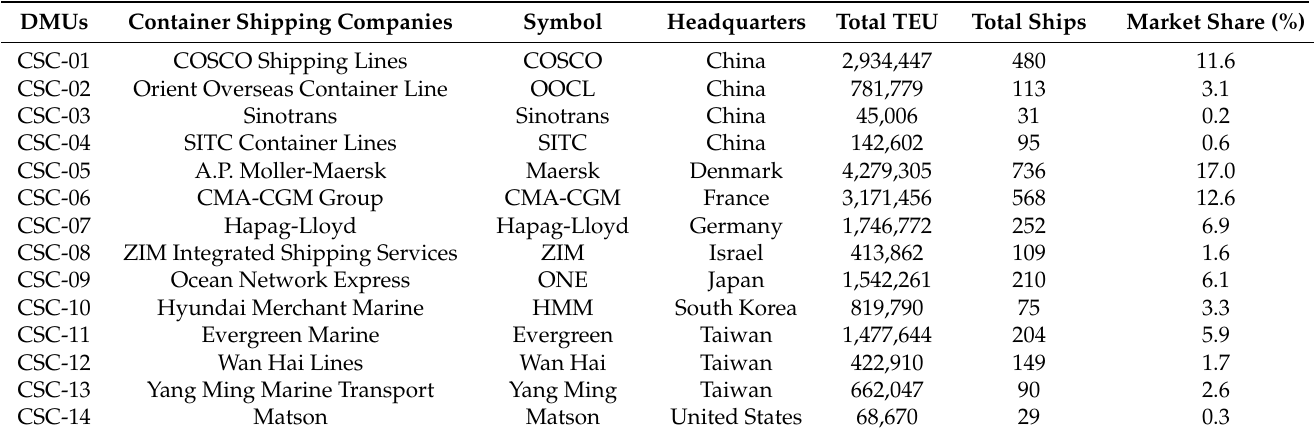
Table 4. The list of container shipping